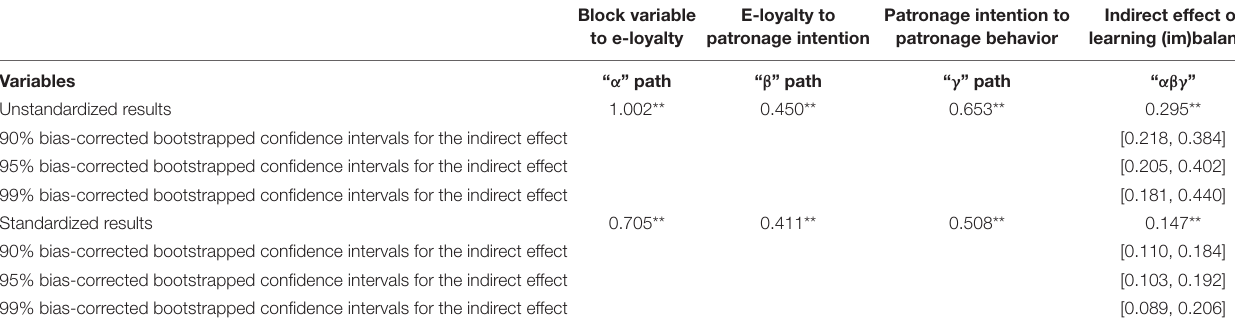
TABLE 5 | Indirect effect of exploratory-exploitative learning balance (imbalance) on patronage